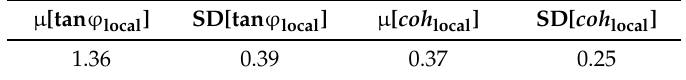
Table 3. Parameters of normal distributions for local friction coefficient and local cohesion.